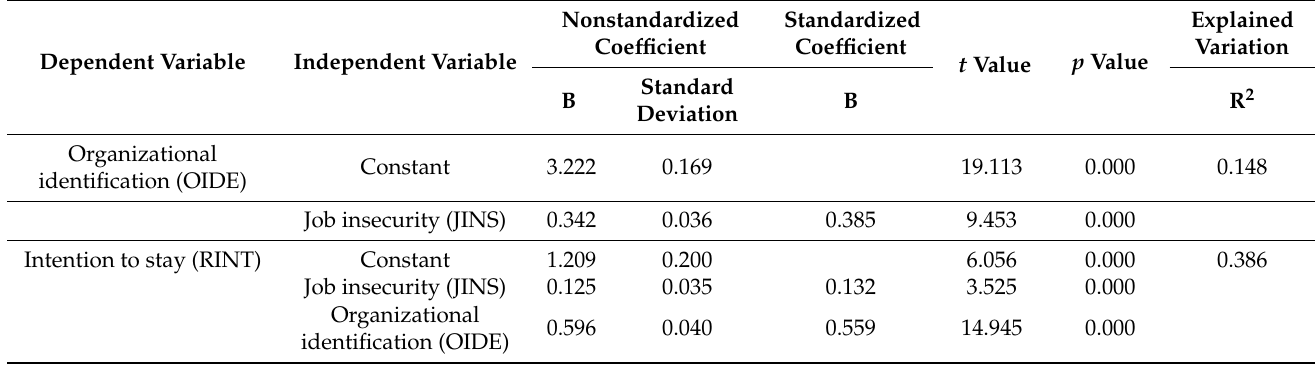
Table 2. Path-analysis-based significance analyses.